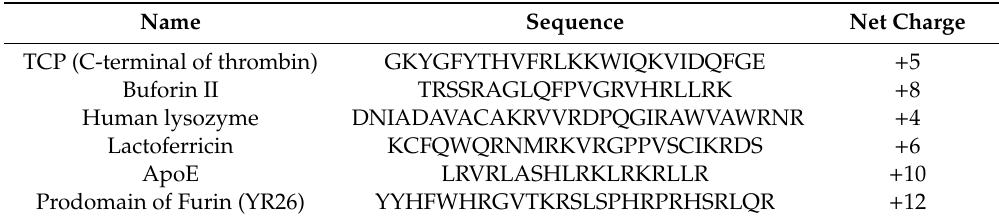
Table 4. Fragments of Intra-cellular Proteins as Potent